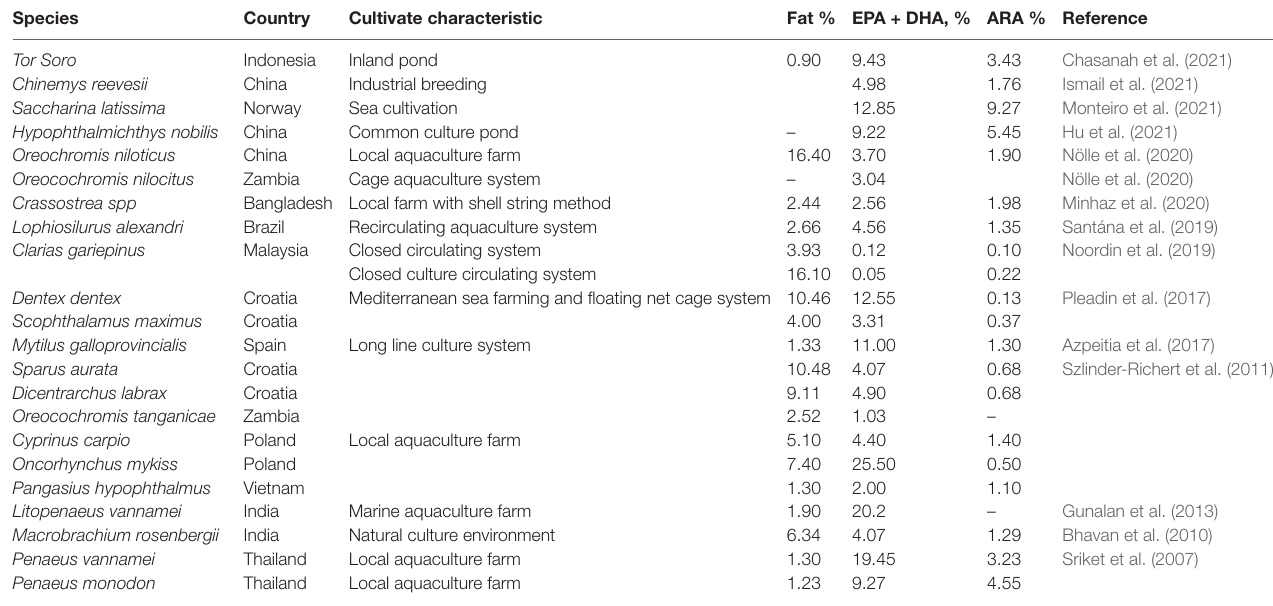
TABLE 2 | The composition of total fat, omega-3 and omega-6 PUFAs of selected cultured species. Species